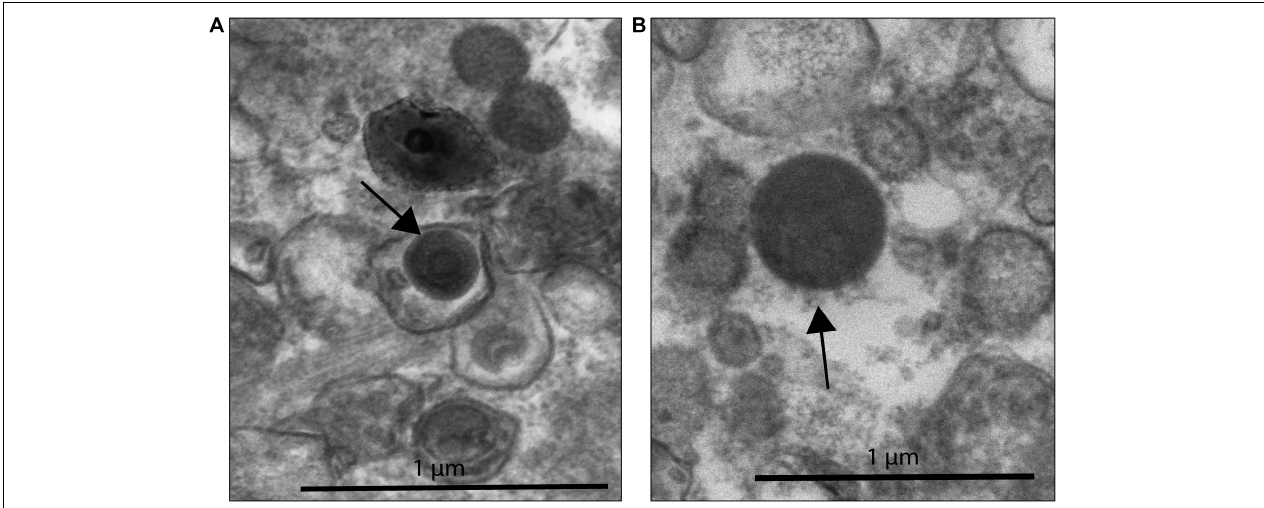
FIGURE 3 | NCLDV-like VLP within B coral samples. (A) VLP surrounded by a vacuole-like structure with a total diameter of ∼ 410 nm (black arrow) found outside of coral cells. This VLP has concentric circles within the capsid structure, a characteristic observed in known NCLDV-like Mimiviridae . (B) VLP ∼ 480 nm in diameter, with possible fibrils (black arrow). Zoomed out image of 3B can be found in Supplementary Figure 4 .